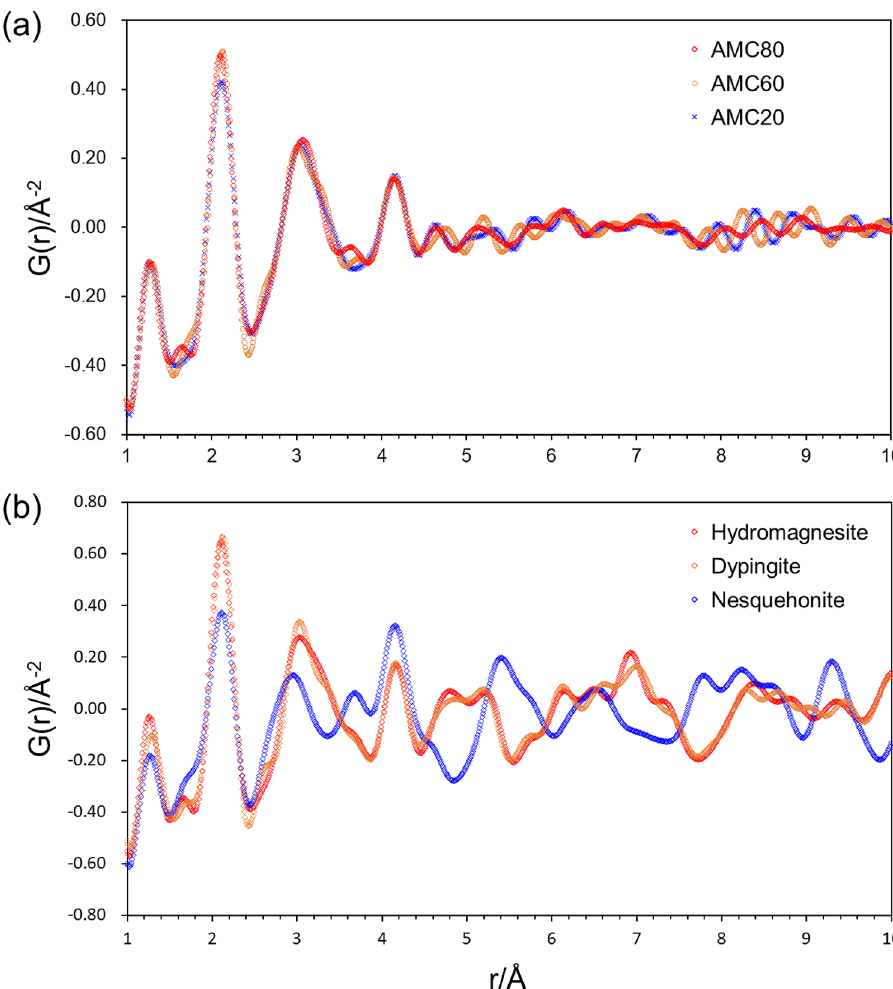
Figure 3. PDF patterns of different crystal structures. (a) AMC samples obtained at 20, 60, and 80 °C (denoted as AMC20, AMC60, and AMC80, respectively). (b) Nesquehonite, dypingite, and hydromagnesite crystalline magnesium carbonate hydrates obtained by stirring AMC suspensions for 2 h at 20, 60, and 80 °C, respectively.